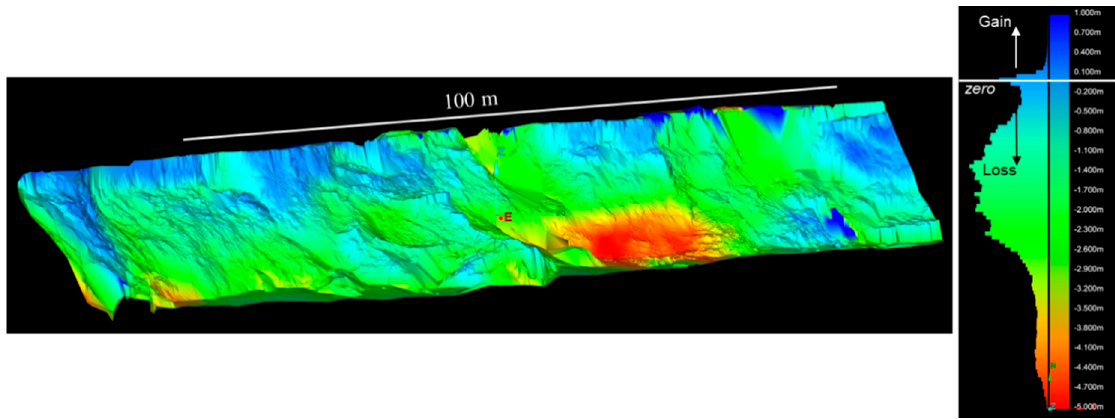
Figure 8. Aldbrough change model, colored by elevation change (February 2016 – March 2017).